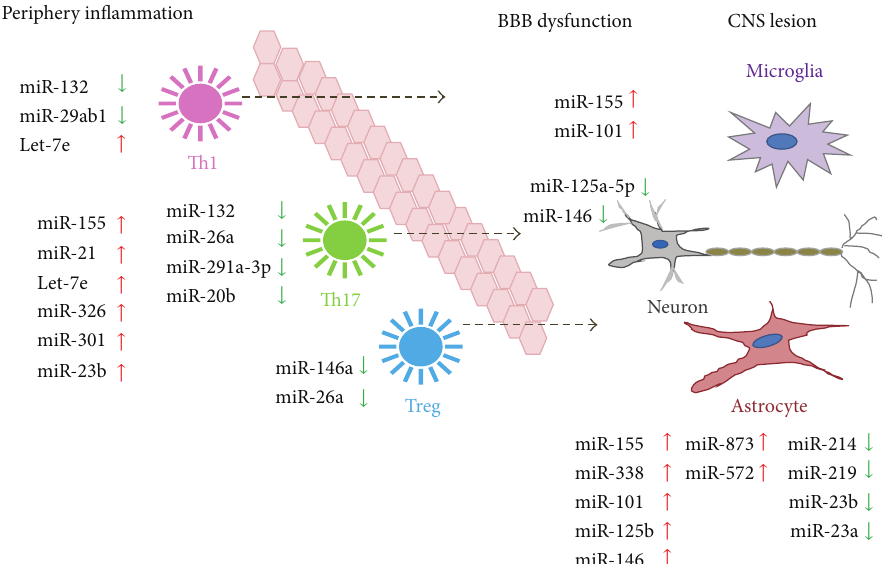
Figure 2: Different miRNA expression in the pathological processes of MS. The changed level of miRNAs is associated with several pathological processes such as periphery inflammation, BBB dysfunction, and CNS lesion. Dysfunction of immune cells including astrocytes and oligodendrocytes in the CNS and Th1, Th17, and Treg cells in the immune system is characterized by different miRNA expressions that are up- (red) and downregulated